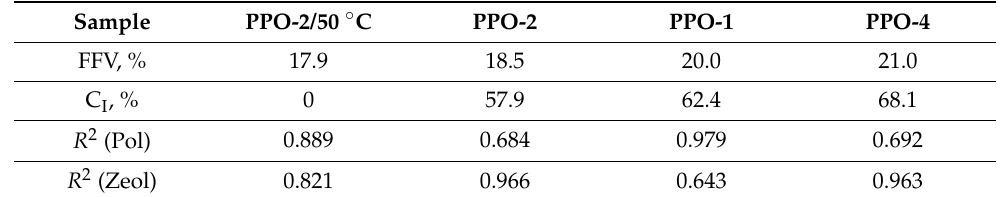
Table 6. Determination coefficients R 2 of linear correlations E D (d 2 ) for two types of kinetic diameter scales: for polymers (Pol) [45] and for zeolites (Zeol) [46].